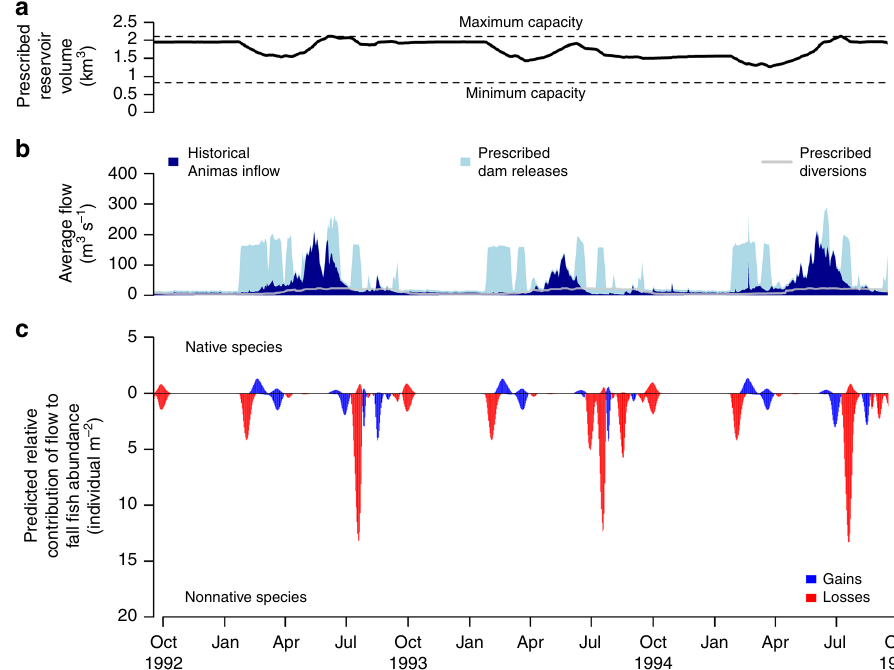
Fig. 3 Designer fl ow prescription balancing human and ecological objectives from 1992 to 1995 during the wet (high- fl ow) period. Designer fl ow prescription indicated by triangle symbol in Fig. 2a. The depicted designer fl ow heavily prioritized human water needs and focused equally on native species abundance gains and nonnative species abundance losses (90%/5%/5% respective priority split). a Prescribed reservoir volume; b Cumulative plot of historical Animas River in fl ow (dark blue) and prescribed Navajo Dam releases (light blue), with prescribed water diversions downstream of Navajo Dam overlaid (gray); c Predicted relative abundance gains (blue) or losses (red) of native (above zero axis) and nonnative (below zero axis) fi shes in response to fl ow designs (individual m − 2 on log